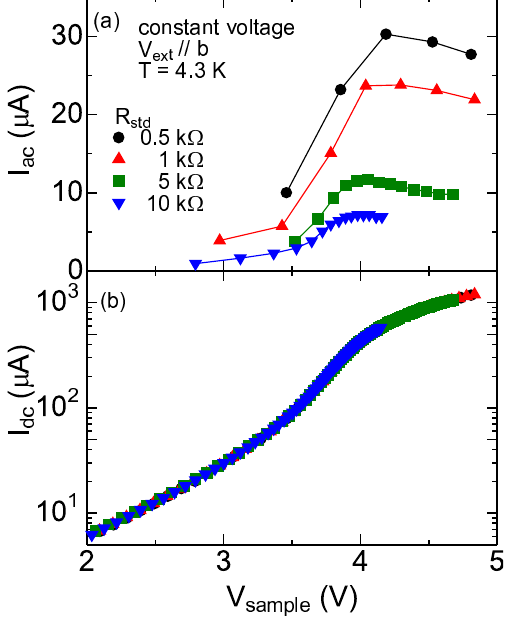
and (b) dc component I of the current oscillation in ac dc measured in constant sample